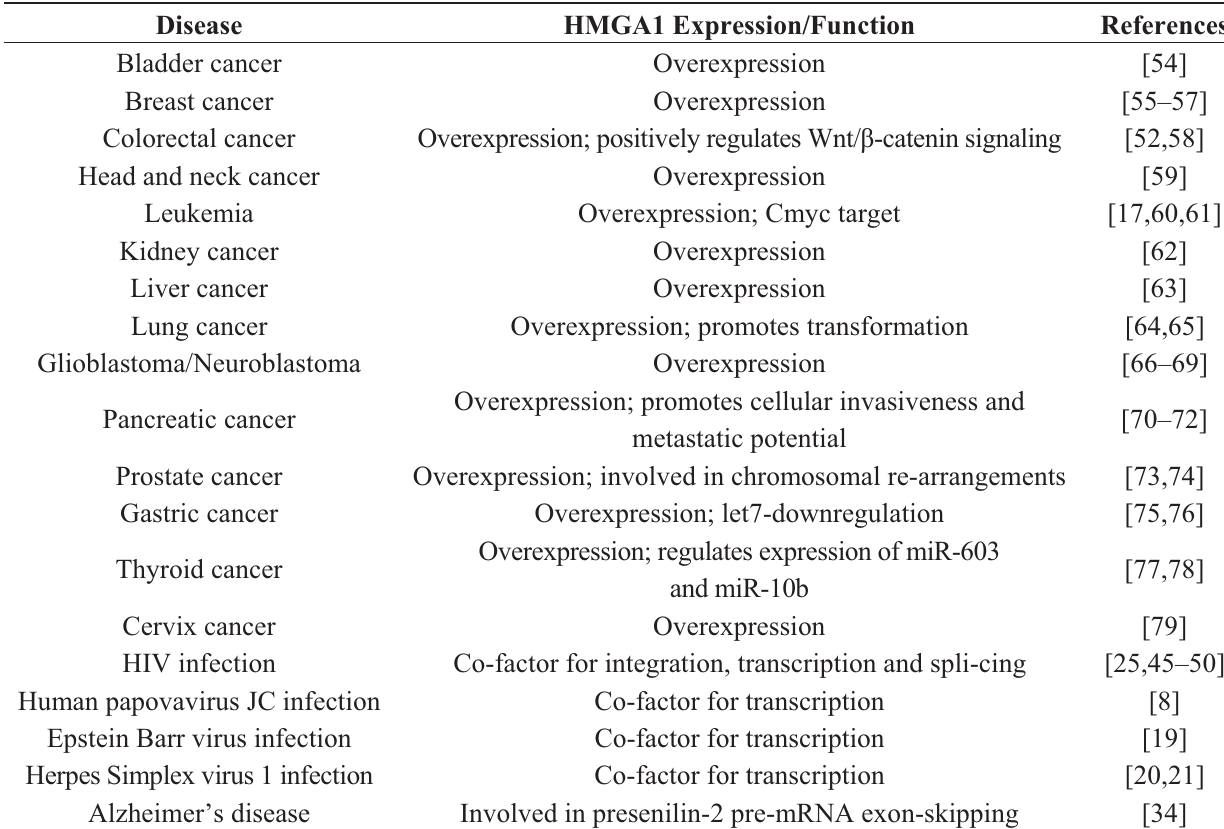
Table 1. HMGA1 association with human